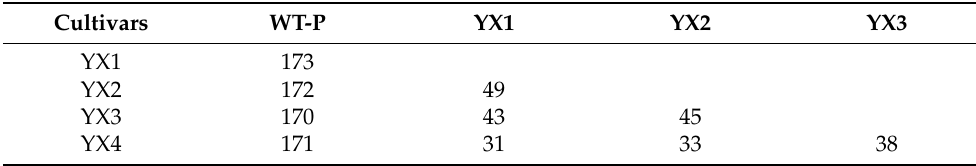
Table 2. Number of InDel markers that were polymorphic in pairwise comparison of five G. paniculata